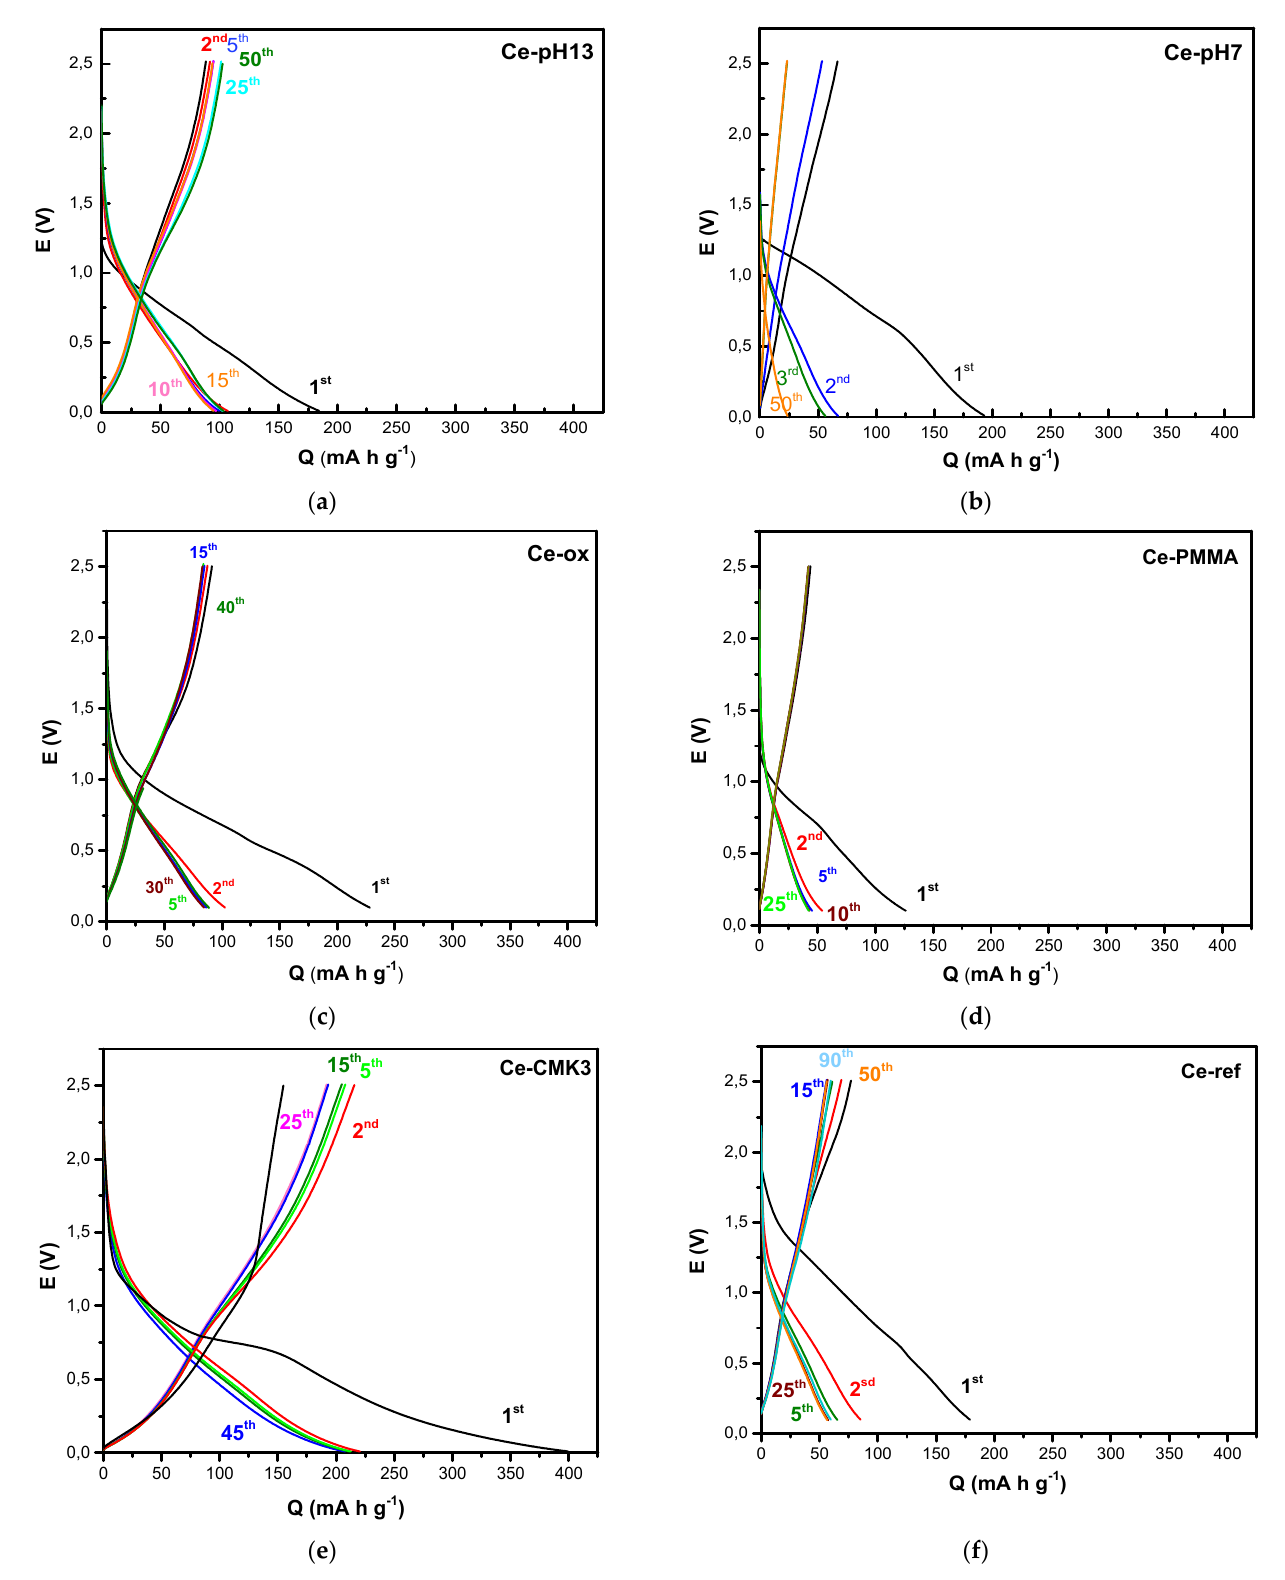
Figure 4. Selected discharge–charge curves at 0.155 A g − 1 current rate for ( a ) Ce-pH13, ( b ) CepH7, ( c ) Ce-ox, ( d ) Ce-PMMA, ( e ) Ce-CMK3 and ( f ) Ce-ref.